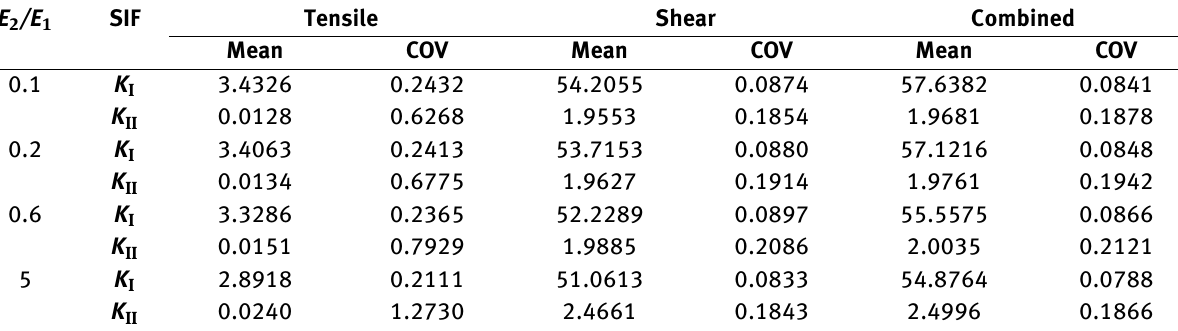
Table 7: Effect of modulus ratios on the normalized mean and COV of K I and K I I of double edge cracked FGMs plate subjected to uniaxial tensile, shear and combined stresses E 2 /E